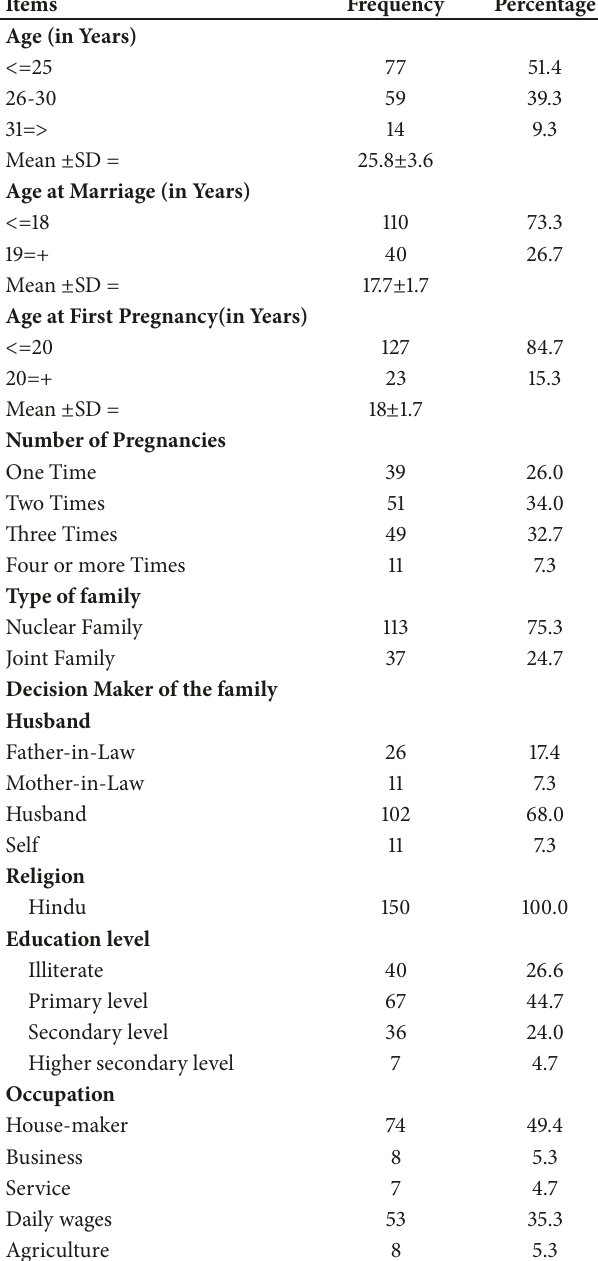
Table 1: Respondents’